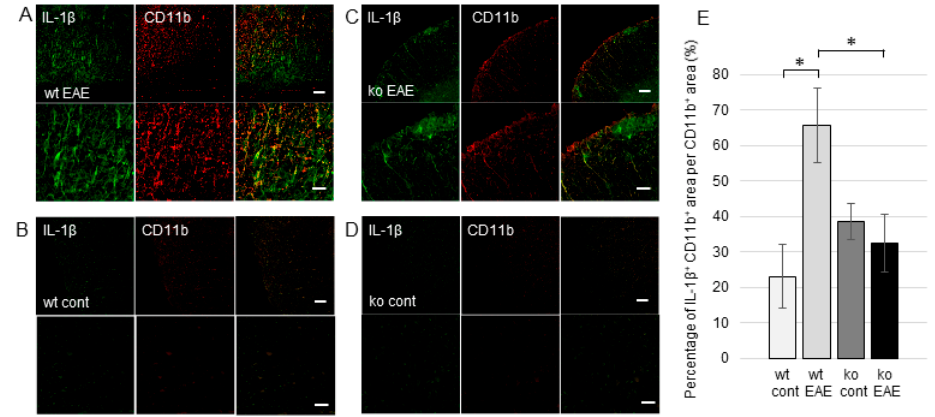
Figure 5. Expression of IL-1 β in CD11b + macrophages and microglia in the spinal cords of EAE and control mice. Immunohistochemistry image showing IL-1 β (green) and CD11b (red) in the inflammatory region of the spinal cords of wt EAE ( A ), wt control ( B ), ko EAE ( C ), and ko control ( D ) mice. Percentage of the IL-1 β + CD11b + area in the CD11b + area of EAE spinal cords ( E ). Scale bar (50 μ m) for upper panels and (20 μ m) for lower panels of ( A – D ). wt, wild-type; ko, mPGES-1 − / − ; cont, naïve mice; EAE, EAE mice. * p < 0.05.